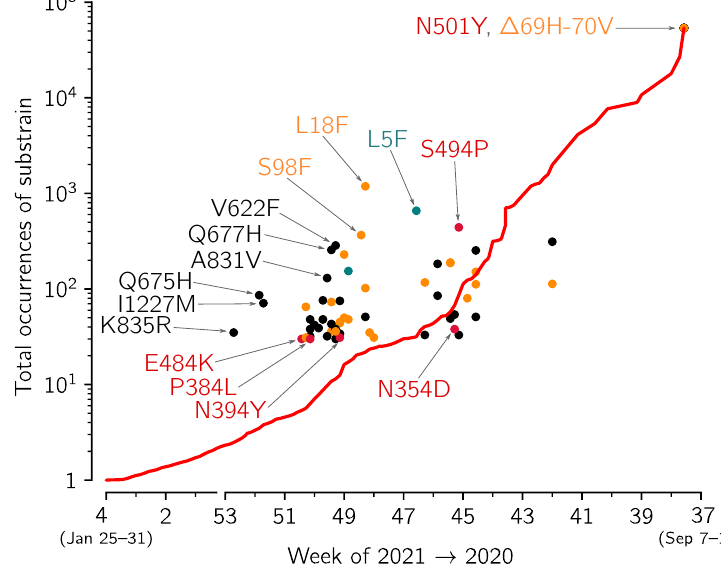
Figure 6. The growth of VOC substrains with respect the whole VOC strain. The figure is based on spike protein sequences from genomes collected in England and submitted to GISAID till 12 February 2021. The growth of the whole VOC strain (red line) in the time span between t and t 0 = 12 February 2021 is calculated as VOC( t 0 )/VOC( t ), i.e., the ratio of the number of the VOC genomes collected till 12 February 2021 and the number of VOC genomes collected till t (date given on horizontal axis). Disks denote VOC substrains defined by particular mutations (with at least 30 genomes submitted); horizontal axis value for each circle is the date of first collection of a sequence with a given mutation; vertical axis value is the number of genomes collected till 12 February 2021, conferring a given mutation. Red, orange, and green circles denote substrains with leading mutation in respectively in RBD, NTD, and signal peptide; black circles denote mutations in other domains. Selected substrains that may have replicative advantage and all substrains with the leading mutation in RBD are annotated. Detailed data that were analyzed to prepare this figure are provided in Supplementary Data File S1 (sheet